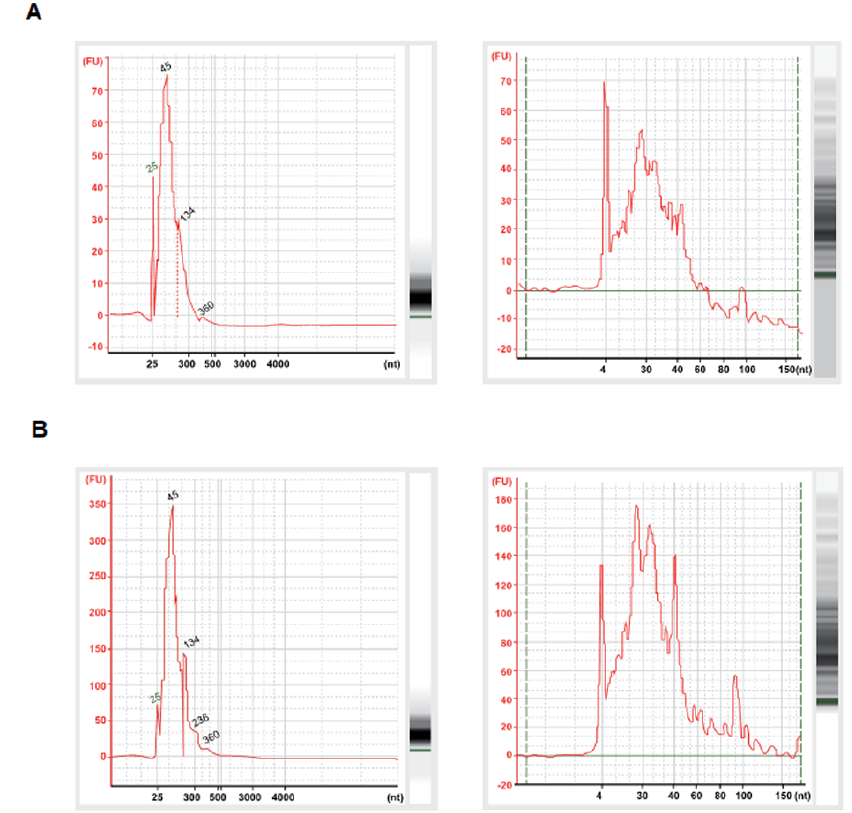
Figure A2. Extracted RNA samples from LSS-sEVs ( A ) and OSS-sEVs ( B ) were assessed for sEVs RNA quality. The sEVs’ RNAs were determined using Agilent Small RNA Chip ( left panel) and Agilent RNA Pico Chip ( right panel) on the Agilent Bioanalyzer 2100. Small RNAs were dominant in the exosomal RNAs.